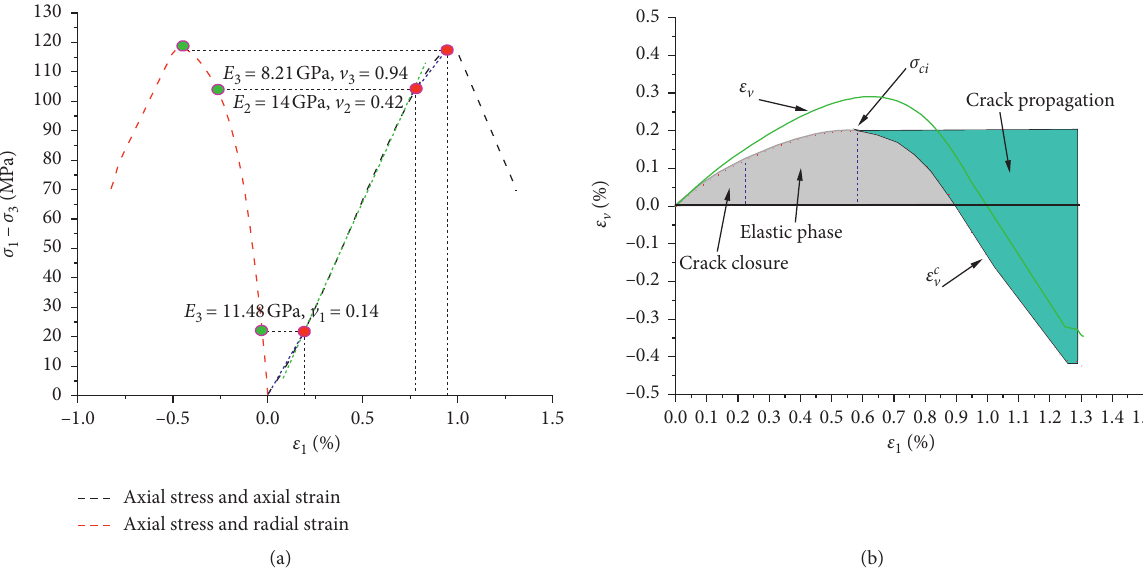
Figure 7: Calculation method of characteristic stress. (a) Modulus and strain aspect ratio at different stages. (b) Initiation stress calculation